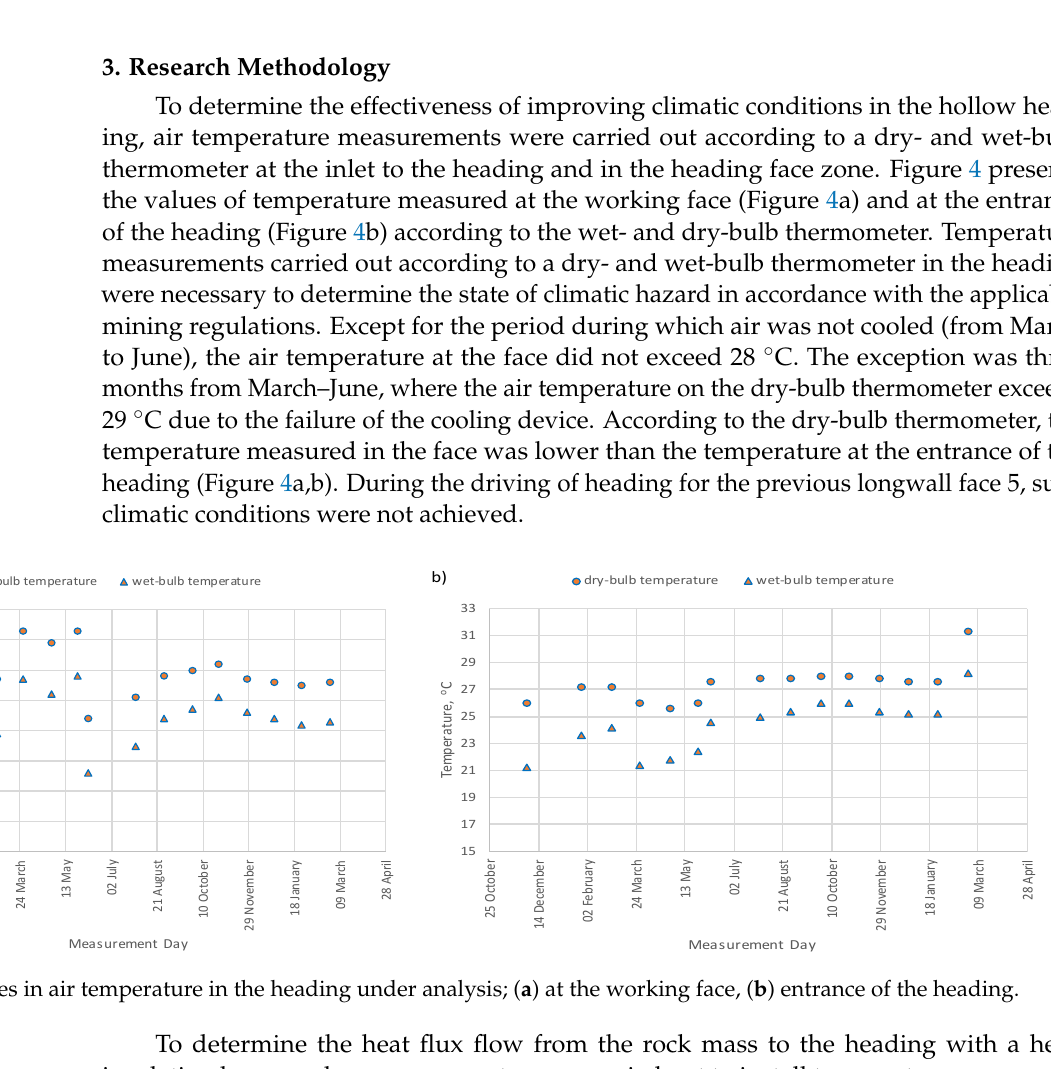
Figure 3. Scheme of the overlap auxiliary ventilation system with methane concentration measurement zones.